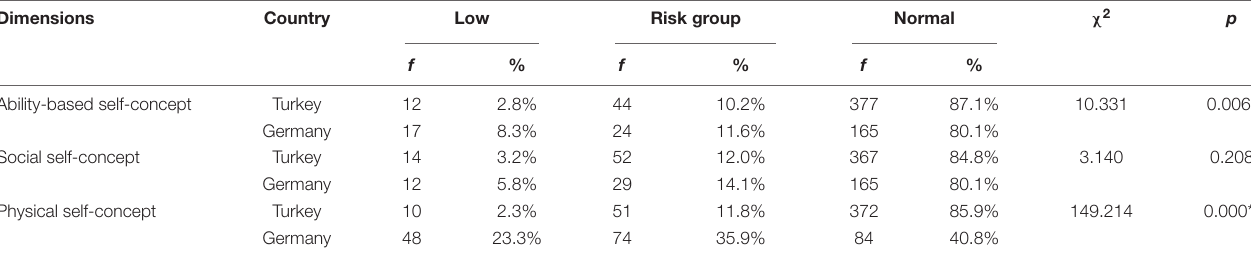
TABLE 3 | Frequency and percentage distribution of children in Turkey and Germany from the dimensions of the self-concept questionnaire for children. Dimensions Country Low Risk group Normal χ 2 p f % f % f %